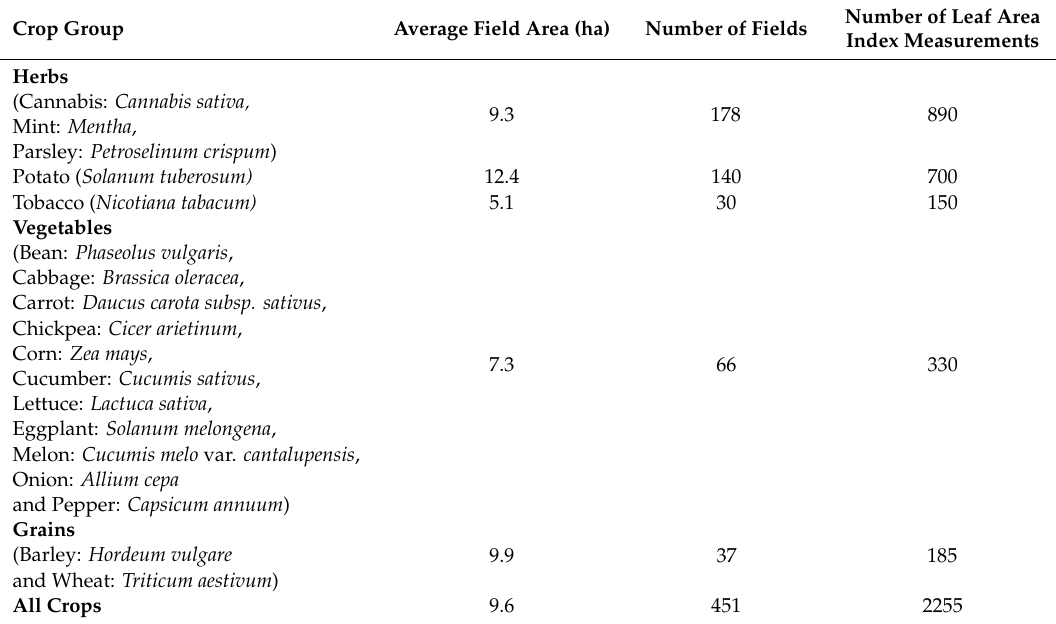
Table 1. Surveyed crop groups during the 2018–2019 growing seasons, the number of fields and their average areas.